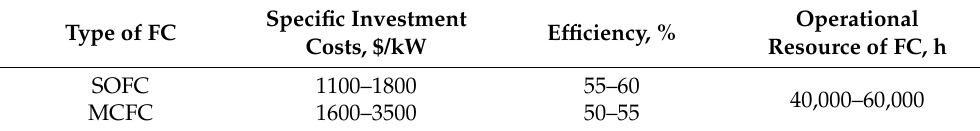
Table 2. Technical and economic characteristics of TPPs predicted for 2030 based on IEA data from IEA (2015) Projected Costs of Generating Electricity, https://www.iea.org/reports/projected-costs- of-generating-electricity-2015, accessed on 15 May 2022 [58]. All rights reserved. Operational Specific Investment Efficiency, % Type of FC Resource of FC, h Costs, $/kW SOFC 1100–1800 55–60 40,000–60,000 MCFC 1600–3500 50–55